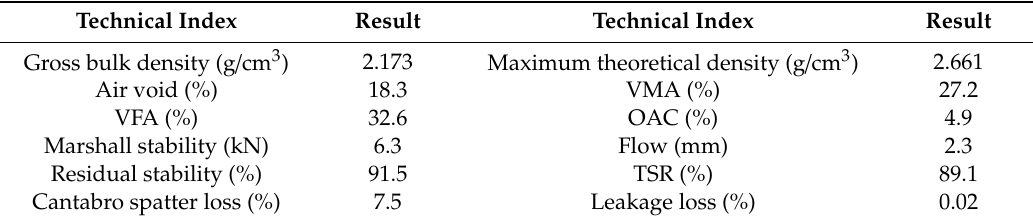
Figure 6. Gradation curve of the large void mixture. Table 2. Main technical indexes of the large void mixture.